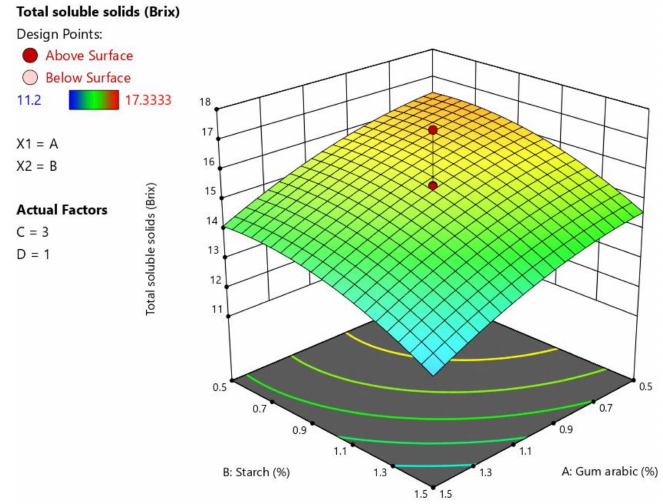
Figure 3. Response surface plot for total soluble solids ( ◦ Brix) of coated “Wonderful” pomegranate as a function of gum arabic and maize starch and concentration.